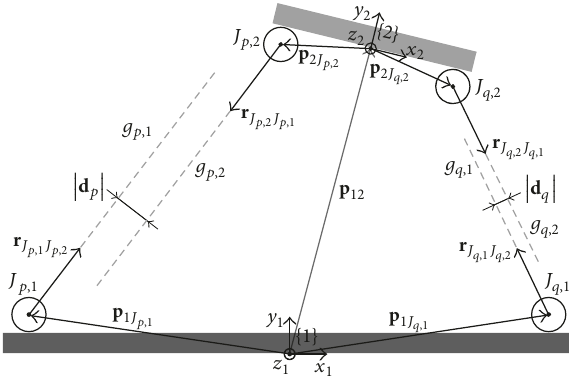
Figure 3: Schematic diagram for the algorithm from Section